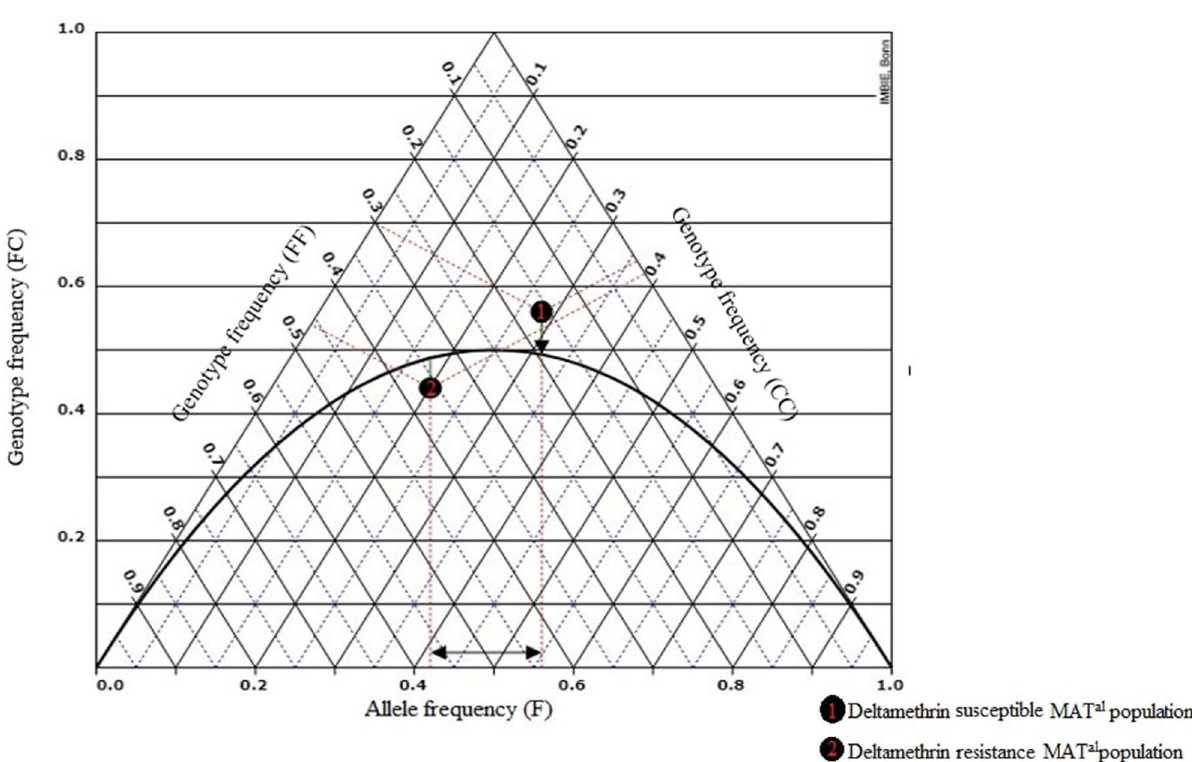
Figure 3. Hardy Weinberg equilibrium (HWE) parabola for deltamethrin resistant (1) and deltamethrin susceptible (2) populations of Ae. albopictus investigated for kdr genotypes, as shown in a De Finetti diagram. The length of the vertical line represented the frequency of genotype FC, the length of the left perpendicular line represented the frequency of genotype FF, the length of the right perpendicular line represented the frequency of genotype CC, the x-axis represented the frequency of allele ‘F’, and the Hardy–Weinberg parabola represented the point where the alleles are in Hardy–Weinberg